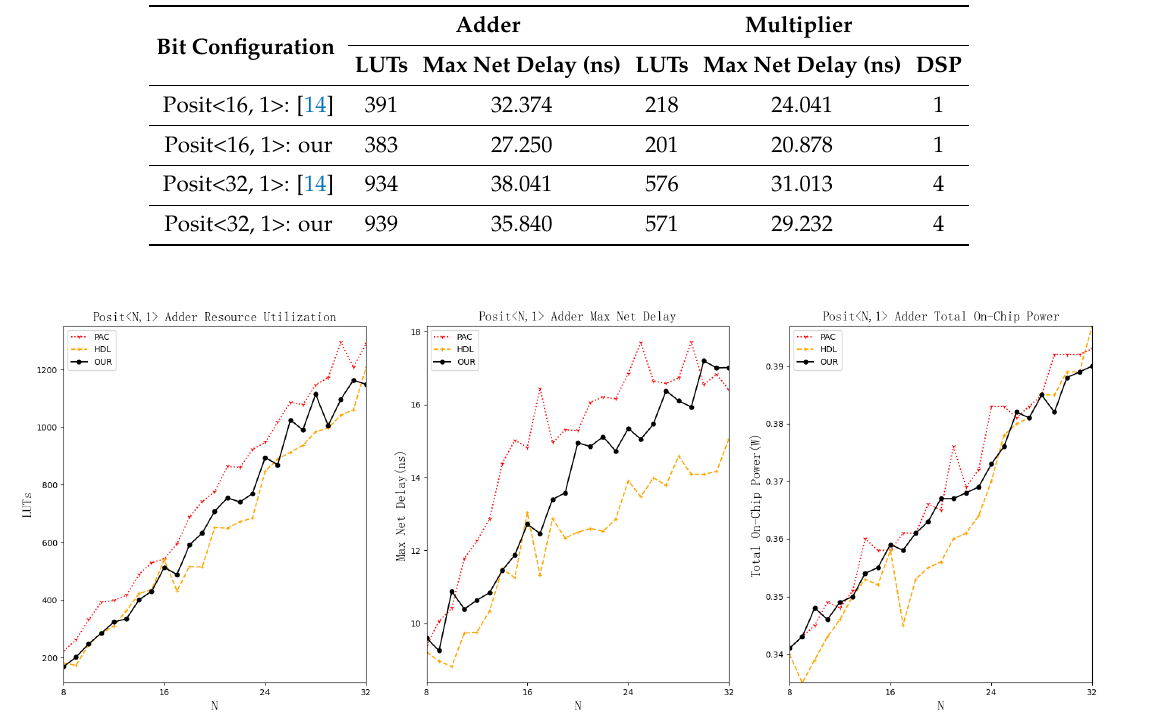
Figure 4. Posit<N,1> adder implementation